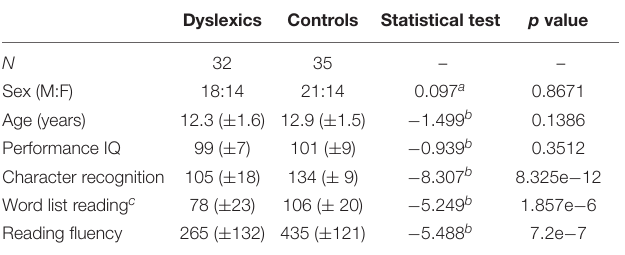
TABLE 1 | Demographics, reading, and cognitive measures ( ± SD) of dyslexic and non-dyslexic children. Dyslexics Controls Statistical test